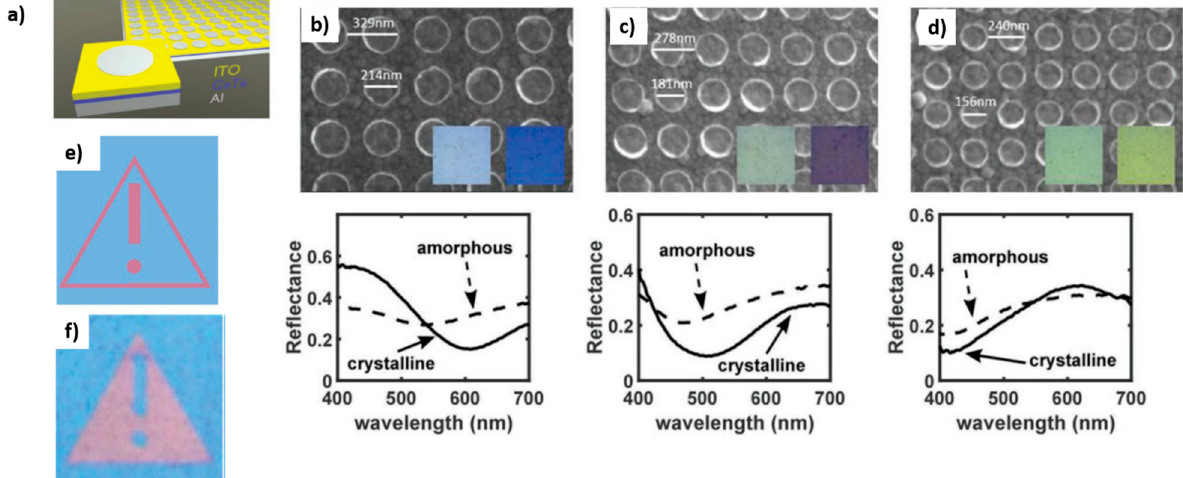
Figure 6. ( a ) Scheme of the structure proposed by Carillo et al. [41] for the obtainment of a colored display, employing a structured metasurface; ( b – d ) SEM images and corresponding Reflectance spectra of cyan ( b ), magenta ( c ) and yellow ( d ) pixels. Color variation is obtained by changing morphological parameter of the metasurface (disk diameter and periodicity), as reported in the SEM images; ( e ) optical picture of fixed bi-color displays, obtained by combining different cyan and magenta pixels in the crystalline state; ( f ) optical picture of dynamic bi-color displays, obtained by combining same cyan pixels, some in the amorphous and some in the crystalline state. Reproduced from Ref. [41] with permission from Wiley.